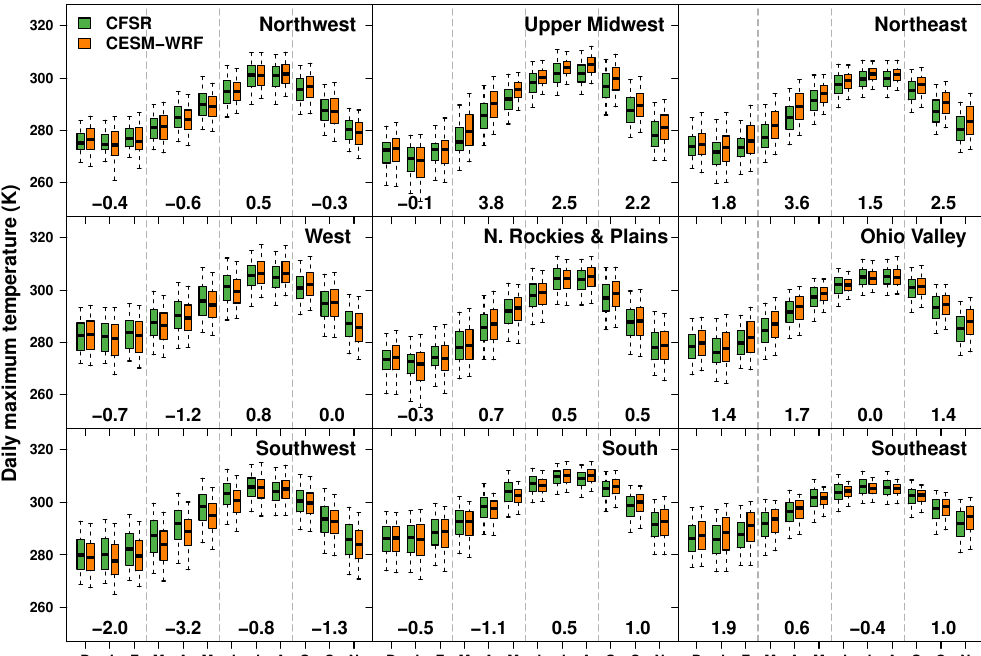
Figure 3. Monthly box plots of daily maximum 2m temperature simulated by downscaling CESM with WRF for the historical 1995– 2005 period compared against CFSR for each of the US climate regions shown in Fig. 1. Boxes range from the 25th to 75th percentiles with the dark line denoting the median, and whiskers extend to 5th and 95th percentiles. Seasonal biases (K) are shown at